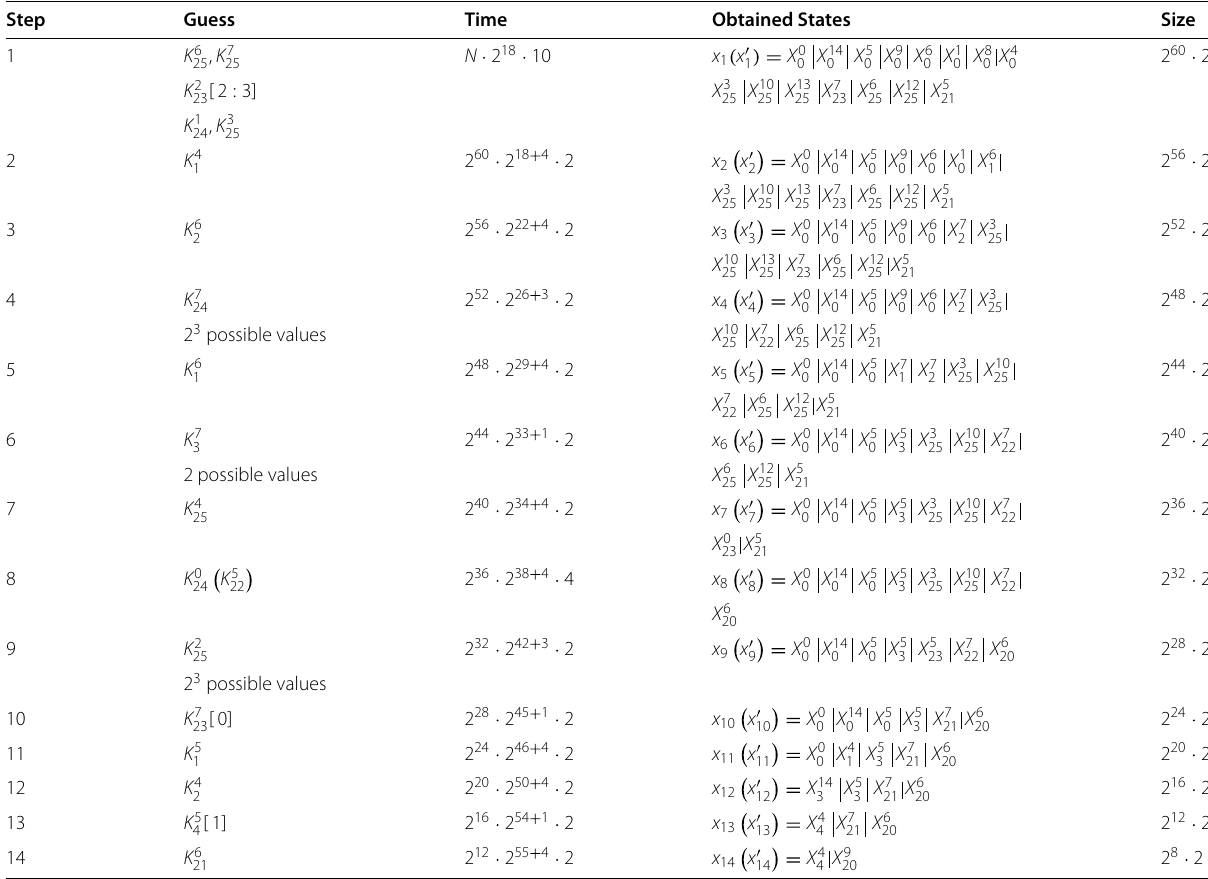
Table 4 Partial encryption and decryption on 25-round LBlock Step Guess Time Obtained States